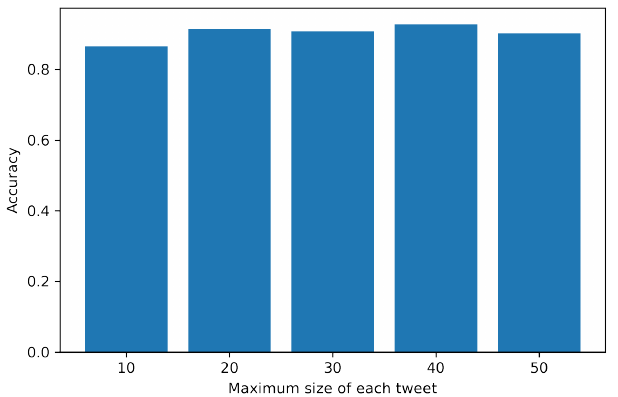
Figure 2. Accuracy of K − fold cross-validation on labeled NLTK tweet data using CNN with varying length of tweet